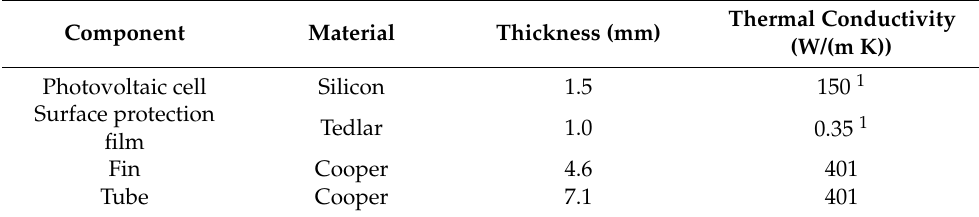
Thermal Conductivity (W/(m K))